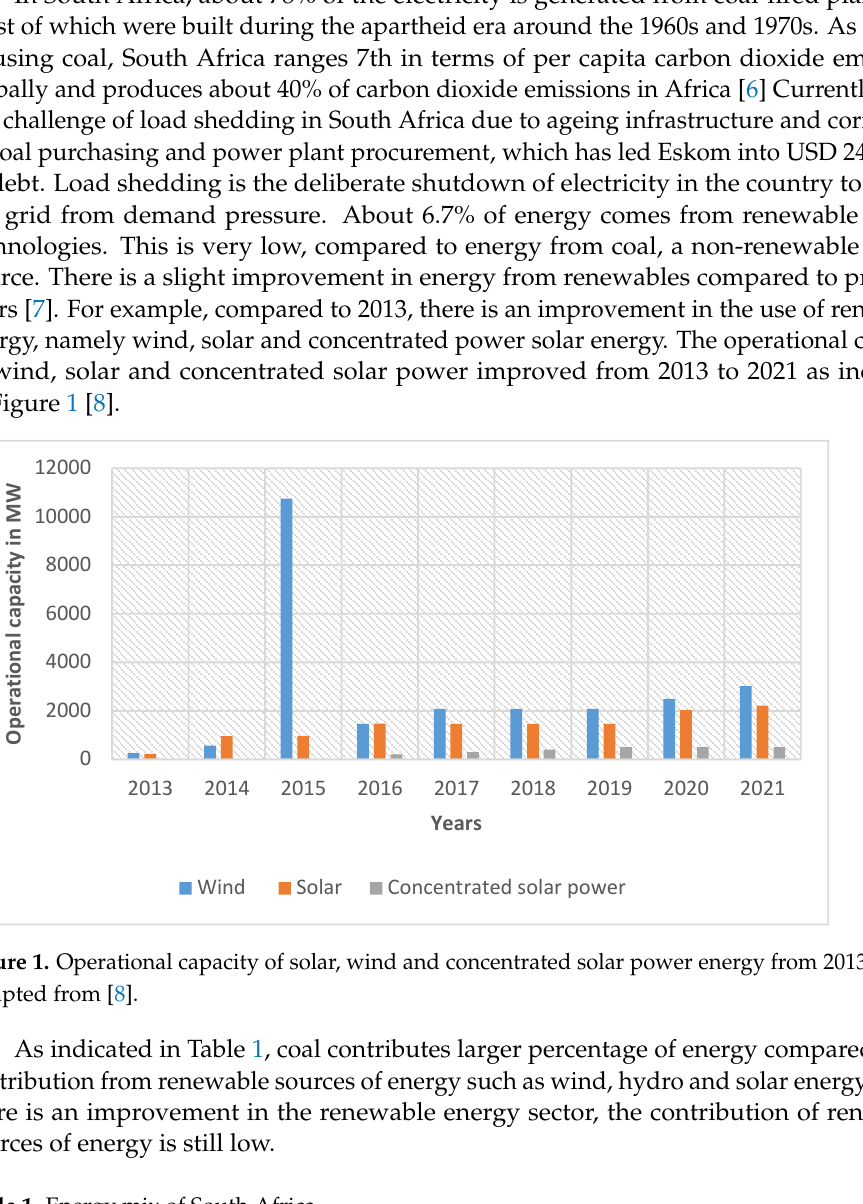
Table 1. Energy mix of South Africa.